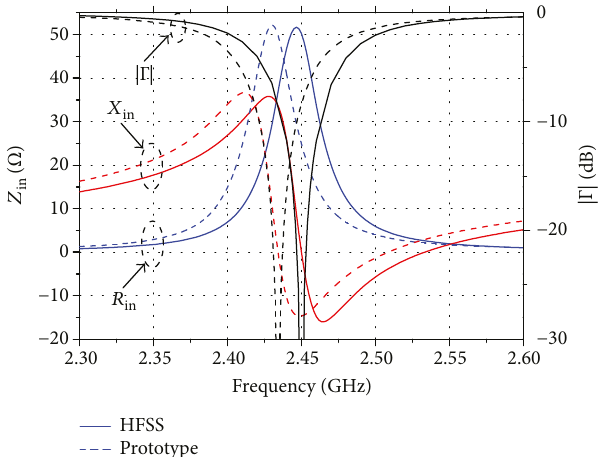
Figure 20: Input impedance and re fl ection coe ffi cient module of the SIW antenna, designed under the null reactance condition.